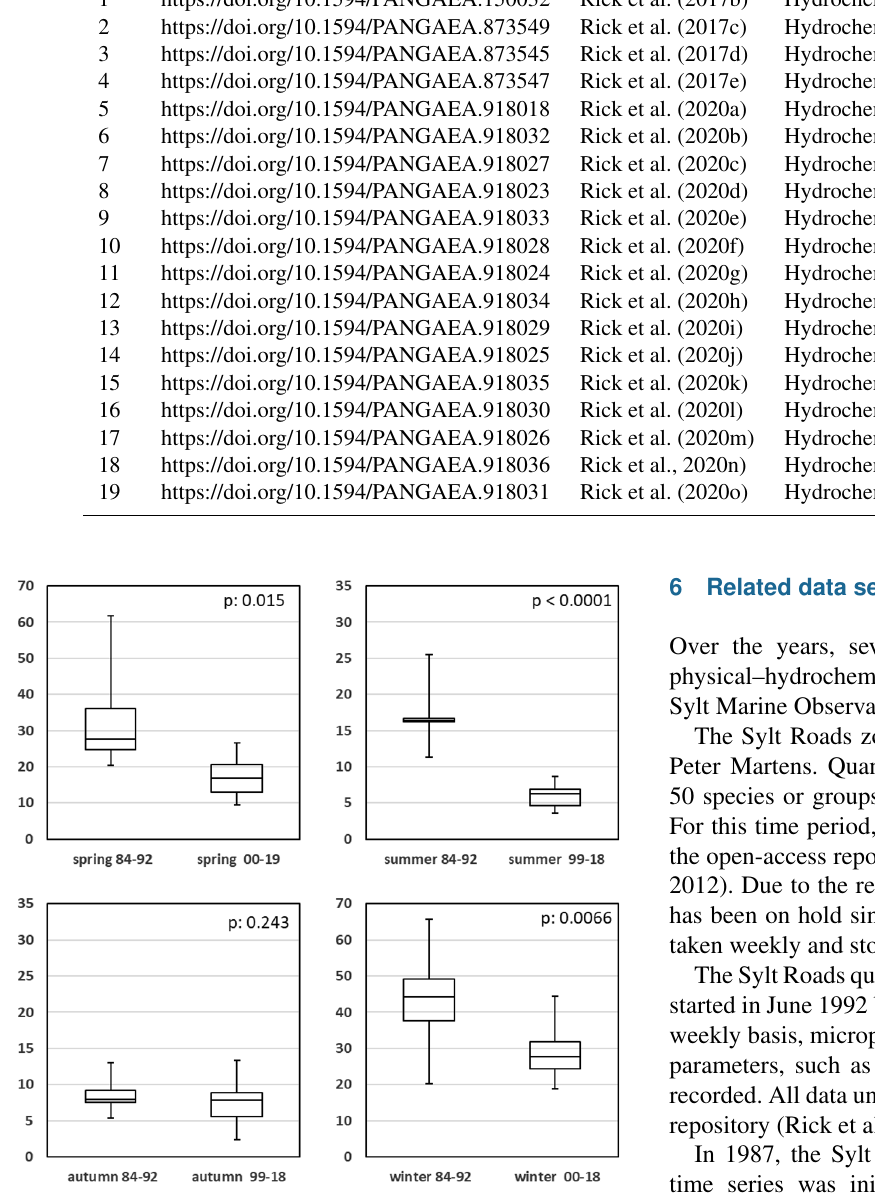
Figure 11. Seasonal comparison of SPM values (mgL − 1 ) for high and low eutrophication